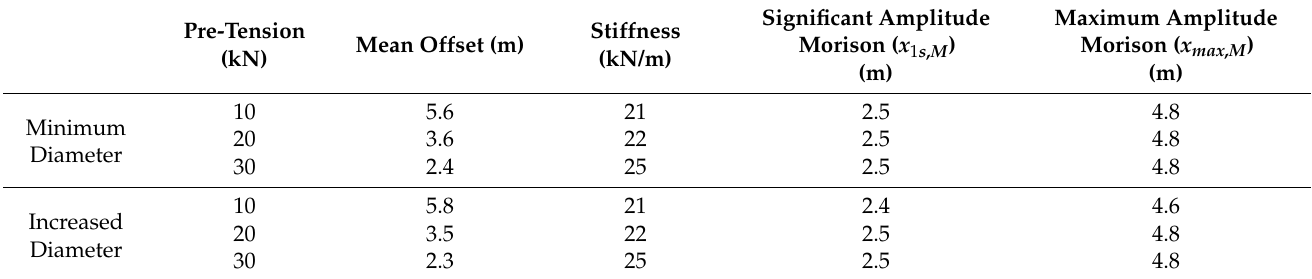
Table 12. Case 2, wave results